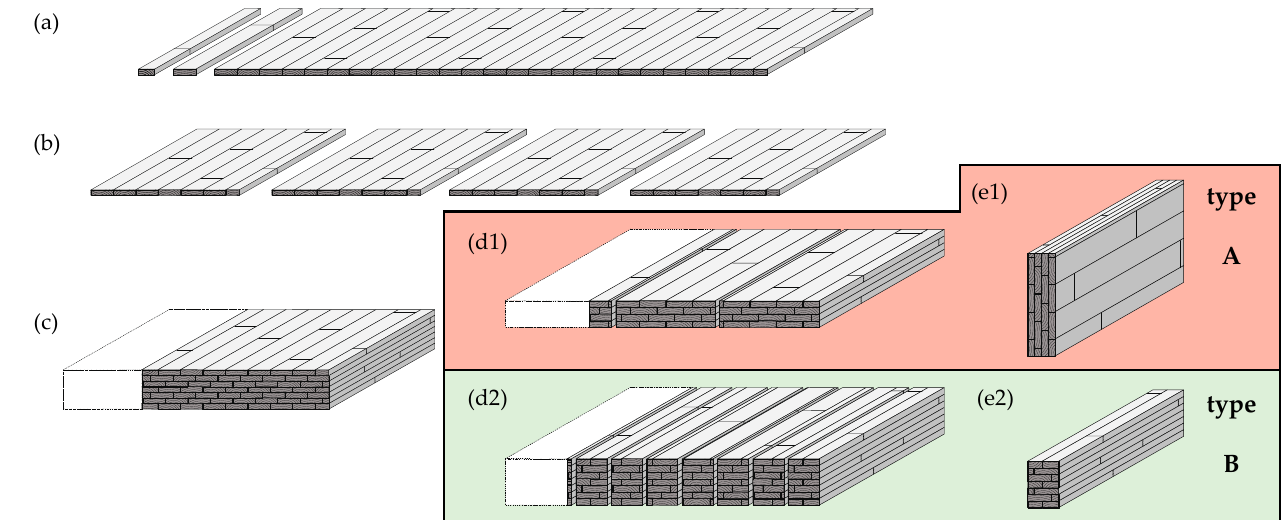
Figure 2. Production of flex_GLT beams: ( a ) finger jointing and edge bonding of strength graded boards to single-layer solid wood panels (SWPs); ( b ) splitting of SWPs to required width; ( c ) face gluing and pressing of SWPs to unidirectionally oriented, large dimensional multi-layer panels; ( d1/d2 ) cut out of flex_GLT-beam elements of ( e1 ) type A and ( e2 ) type B.